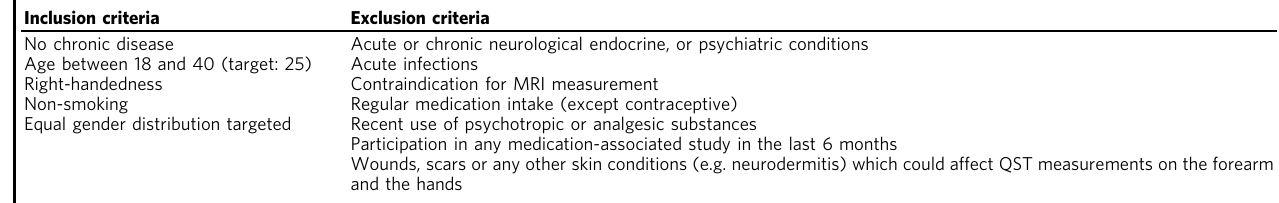
Table 3 Inclusion and exclusion criteria during the recruitment process.